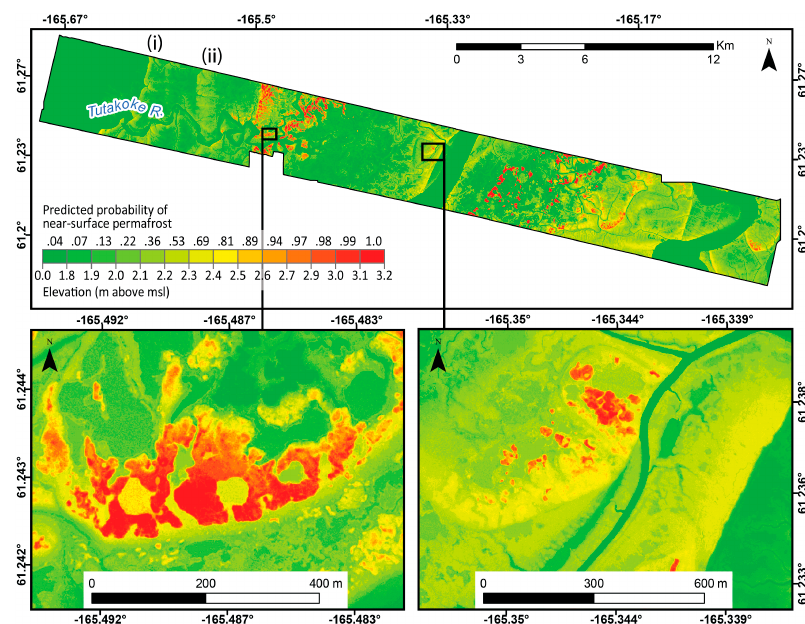
Figure 9. Probability of near-surface permafrost as predicted by 0.1 m elevation bins. The plus signs show permafrost observations (1 = permafrost, 0 = non-permafrost) plotted by elevation; permafrost only occurs at the top of the plot (probability = 1), and absence of permafrost only occurs at the bottom (probability = 0) because of the binomial nature of sampling.